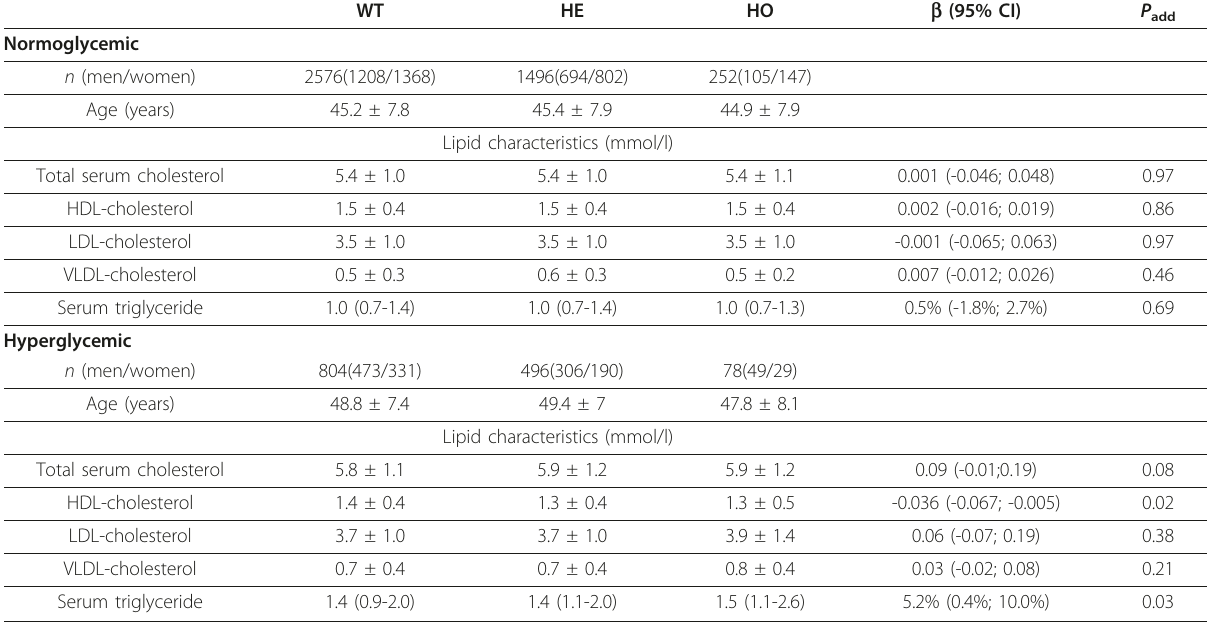
Table 2 Fasting serum lipid levels of successfully genotyped normoglycemic and hyperglycemic Danes from the Inter99 cohort stratified according to ACADS rs2014355